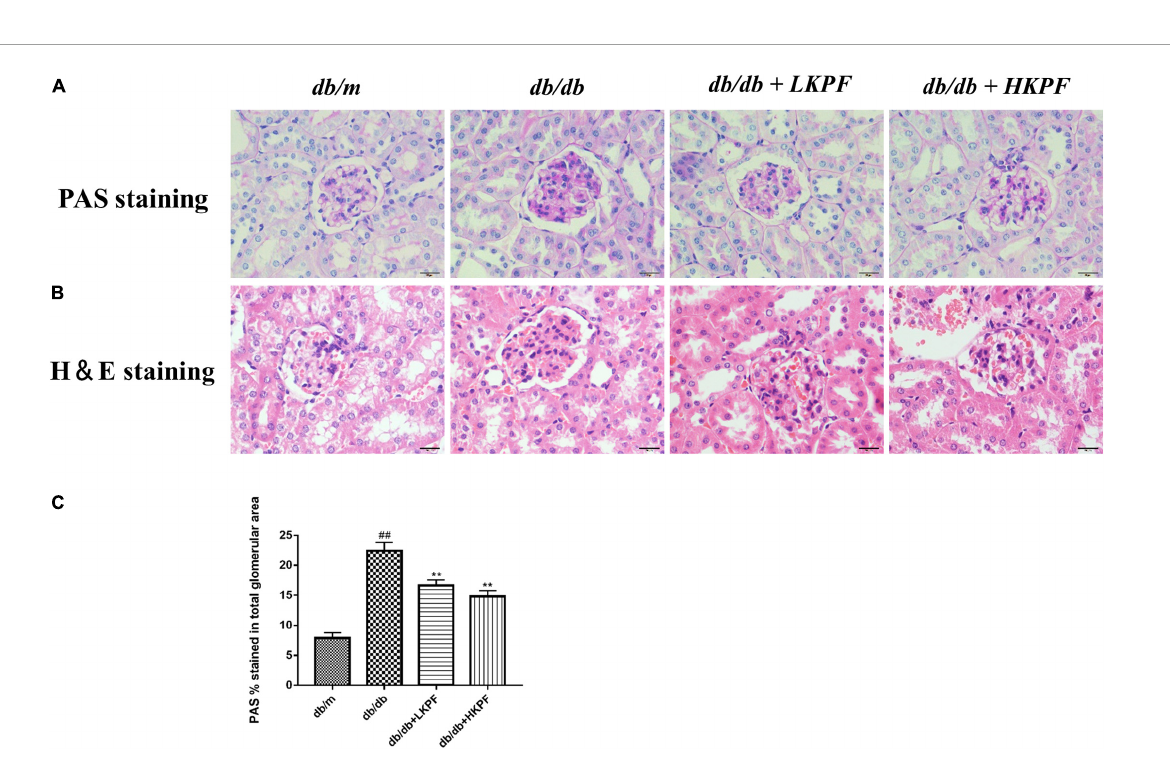
FIGURE2 Kaempferol ameliorated renal histological damage in db/db mice (400 × , bar = 20 µ m). (A) Kaempferol treatment ameliorated glomerular mesangial matrix deposition in db/db mice (PAS staining). (B) Kaempferol treatment ameliorated morphology in the kidneys of db/db mice (H&E staining). (C) Quantification of PAS stained (the glomerular mesangial matrix area) for each group. The data were presented as the mean ± SD ( n = 5, ## p < 0.01 vs. db/m mice; **p < 0.01 vs. db/db mice). H&E, Hematoxylin and Eosin; PAS, Periodic